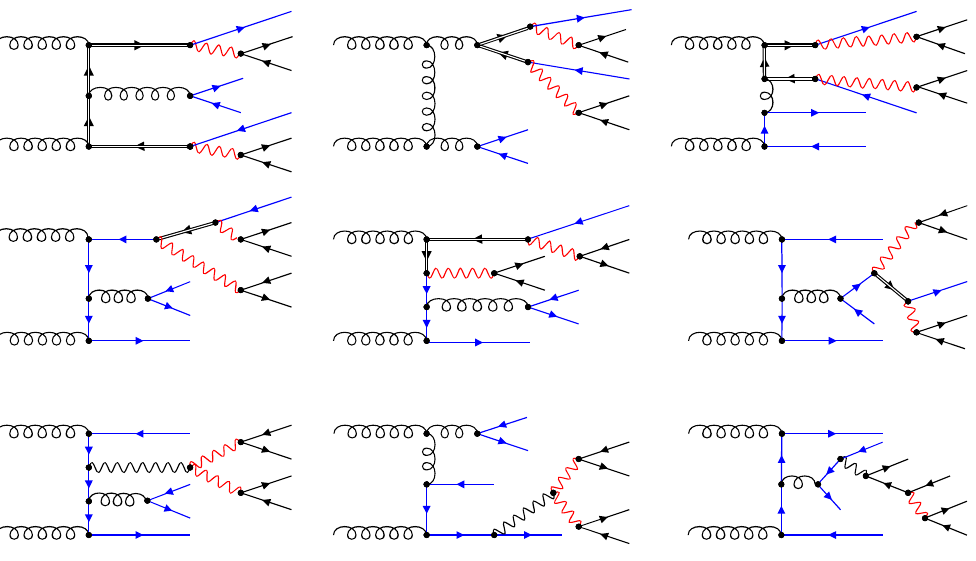
Figure 2 . Representative tree level Feynman diagrams for the pp → e + ν e µ − ¯ ν µ b ¯ b b ¯ b + X process at O ( α 4 α 4 ) . Diagrams with two, only one and no top-quark resonances are presented. The double s line indicates the top (anti-top) quark, the blue line corresponds to the bottom (anti-bottom) quark whereas the W gauge boson is depicted in red. Also shown is a diagram that contributes to the finite W width corrections.